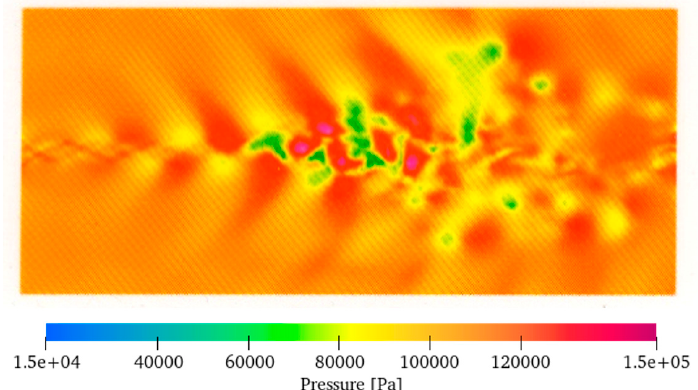
Figure 13. ( a ) Directivity of the predicted noise level in dB from the large-scale simulations of supersonic jet noise (Ref. [57]). Compared with ( b ) the corresponding experimental data (Ref. [59]).